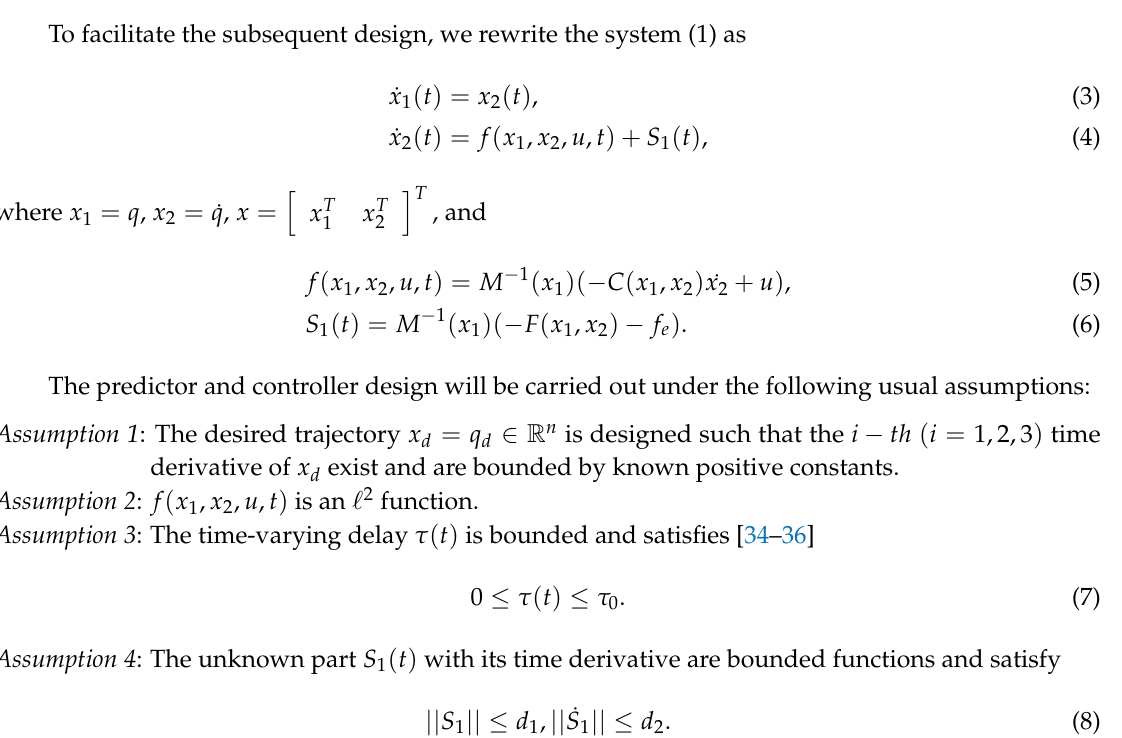
Figure 1. Control structure of cloud robot system with delayed